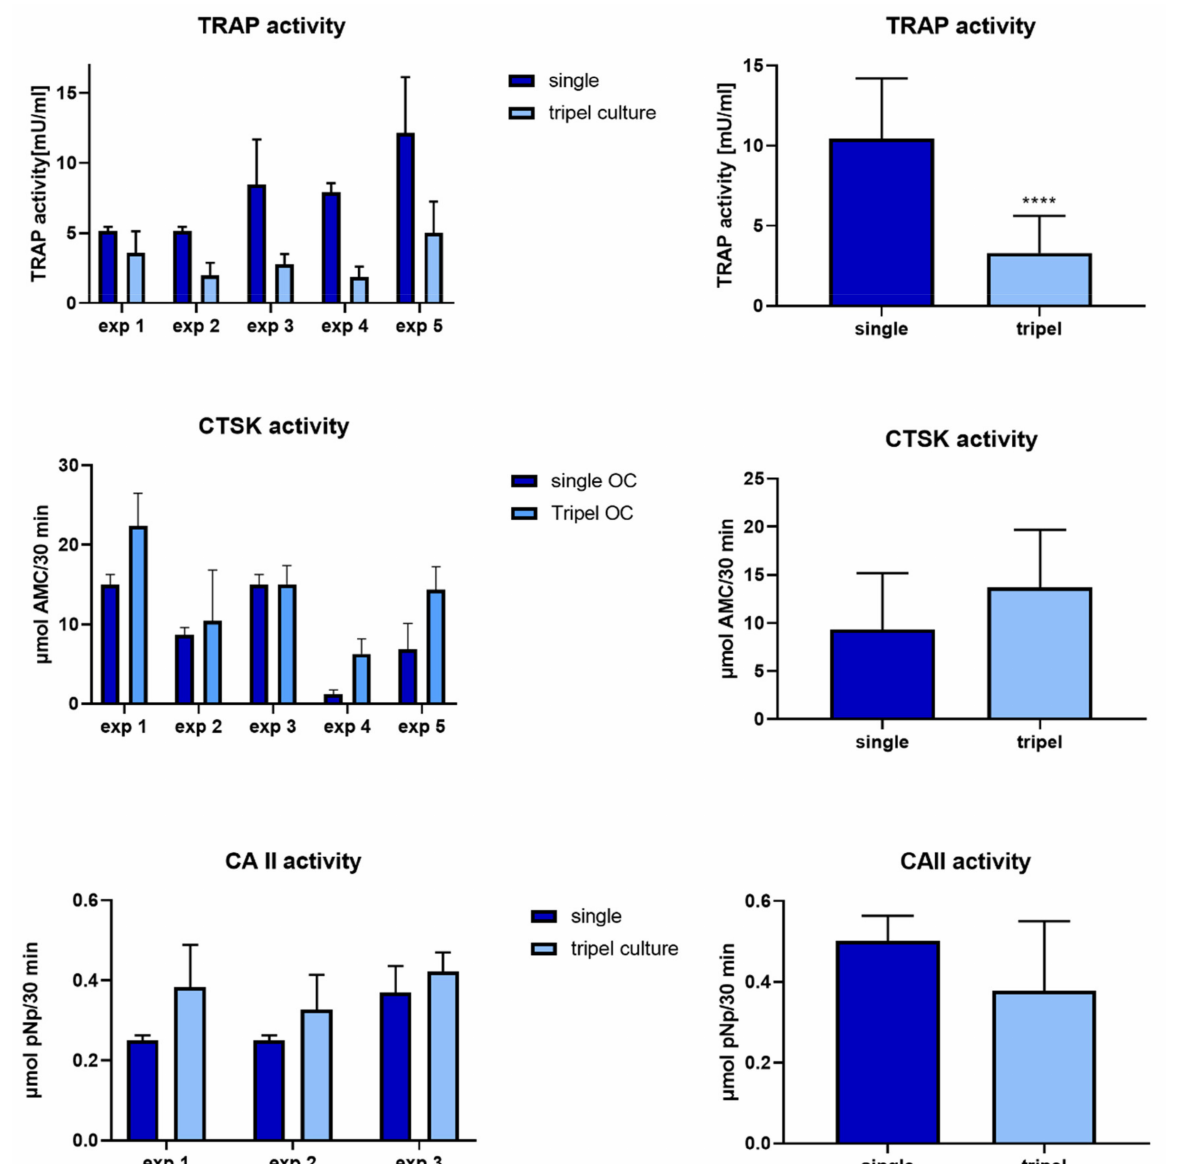
Figure 5. Activities of osteoclast-specific enzymes TRAP, CTSK and CAII for osteoclasts cultivated in single culture compared to triple culture. Average +/ − standard deviation for each experiment (left column) and for all five experiments together (right column). **** p <